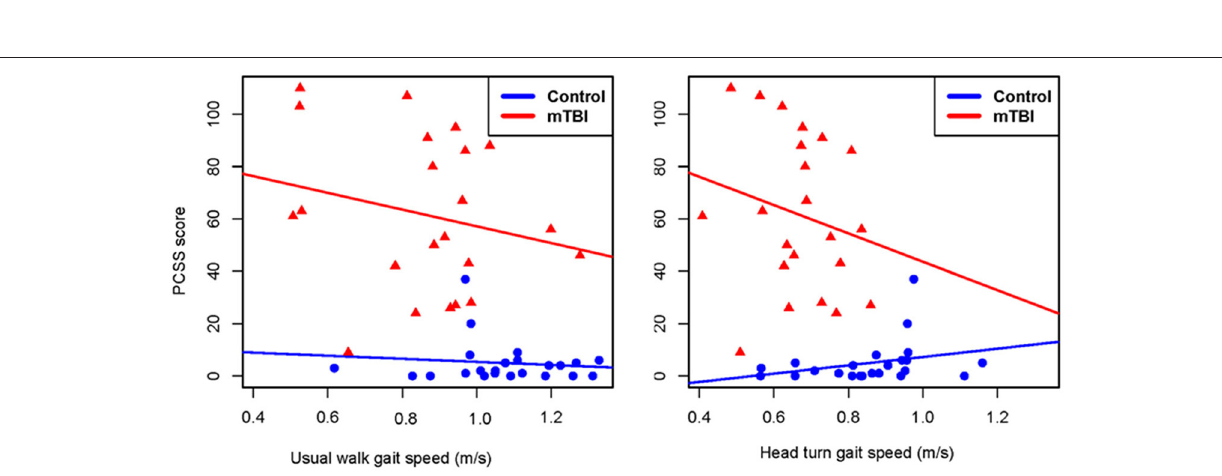
FIGURE 5 | Correlation plots showing the relationship between gait speed during usual walk and head turn walk and post-concussion symptom severity in people with mild traumatic brain injury and controls. PCSS, post-concussion symptom scale; mTBI, mild traumatic brain injury.